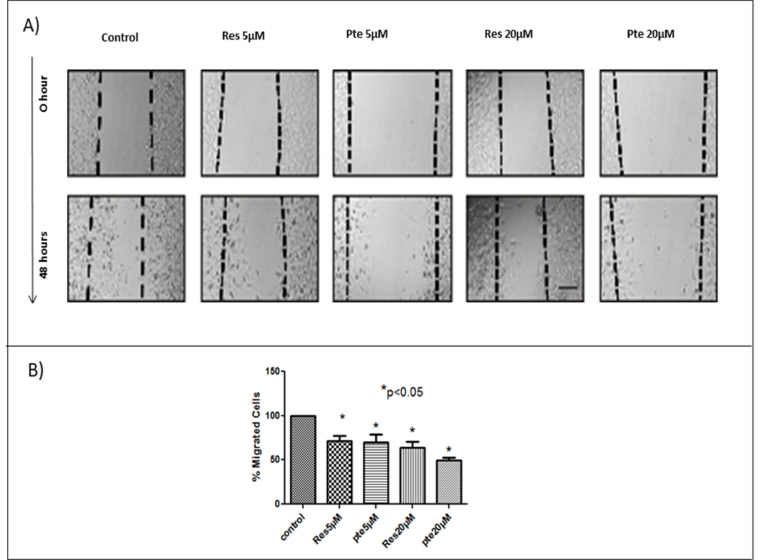
Figure 2. Resveratrol and pterostilbene inhibit cell migration: ( A ) HeLa cells were monitored for cell migration into a scratched “wound”. Cells were either untreated or treated with sub-lethal concentrations (5 µ M and 20 µ M) of resveratrol (Res) or pterostilbene (Pte). The extent of migration into the scratched area was calculated after 48 h and revealed that both resveratrol and pterostilbene significantly inhibit cell migration, although pterostilbene had greater anti-migratory effect. ( B ) The graphs represents data from triplicate sample experiments normalized to the control (mean % migrated cells ± S.E.M.; * p < 0.05). Scale bar: 0.05 µ